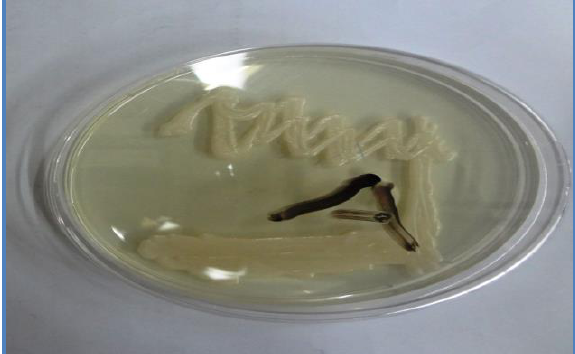
Figure, 1: Candida albicans on sabouruad dextrose